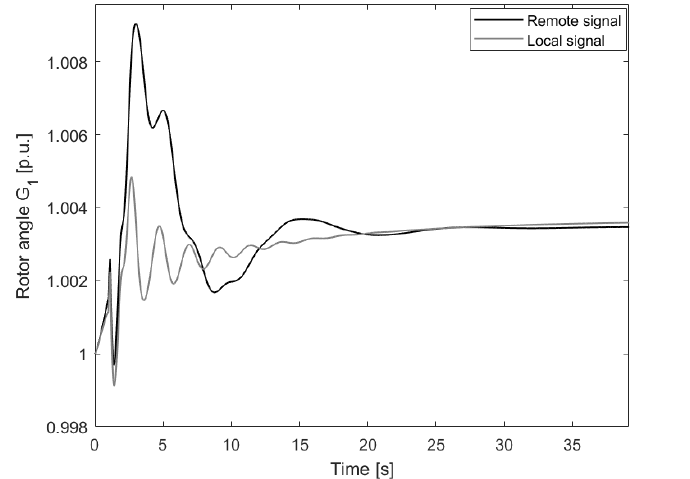
Figure 15. Effect of input signal location on the rotor angle of G 1